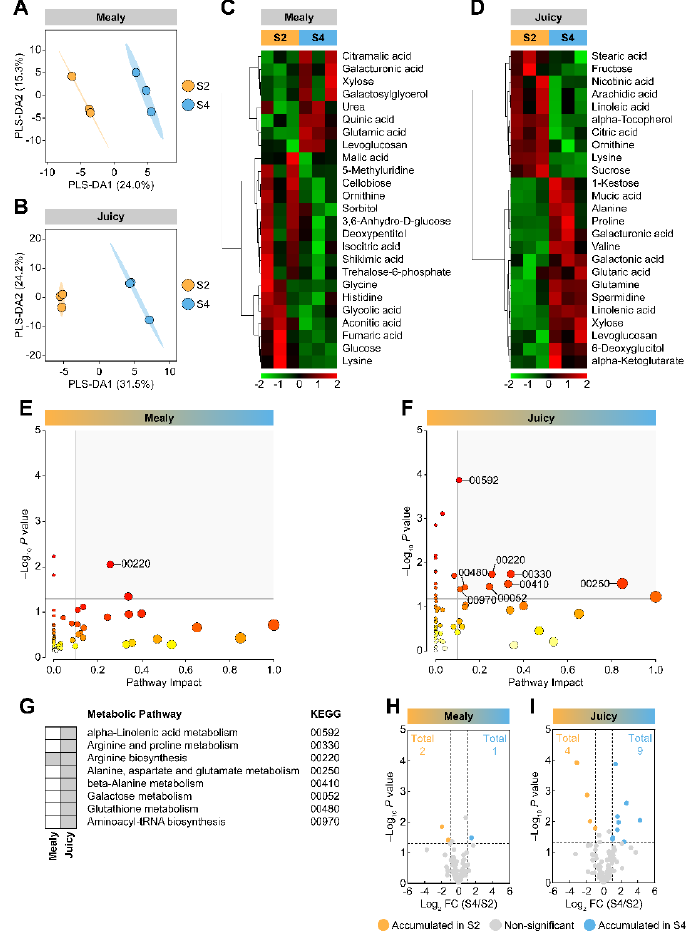
Figure 3. Multivariate analyses of metabolites of mealy and juicy ripe nectarines after cold storage. Partial Least Squares Regression Discriminant Analysis (PLS-DA) for S2 and S4 stages and score plot of mealy ( A ) and juicy ( B ) varieties. The identified metabolites were employed as predictor variables and the varieties as response variables. Heatmap representation based on top 25 metabolites identified by PLS-DA VIP of S2 and S4 stages from the mealy ( C ) and the juicy ( D ) varieties. The columns represent biological replicates for each treatment. The similarity measure used to group the different characteristics was based on Euclidean distance and Ward’s linkage from three biological replicates ( n = 3). Pathway analysis of S2 and S4 stages from the mealy ( E ) and the juicy ( F ) varieties. Perturbed metabolic pathways and their KEGG entry are highlighted in grey ( G ). Three biological replicates ( n = 3) and the Arabidopsis thaliana pathway library were used for this analysis. Volcano plots showing differentially accumulated metabolites (DAMs) from mealy ( H ) and juicy ( I )